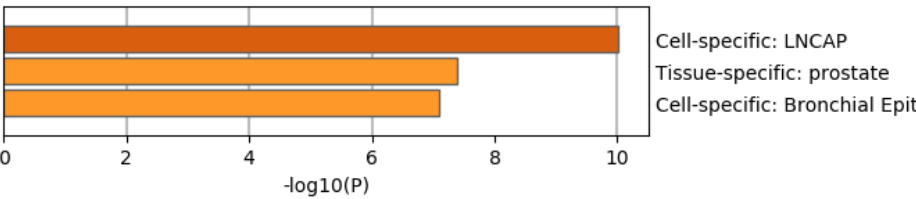
Figure 8. Summary of enrichment of the PaGenBase category of Metascape when 1785 protein-coding genes included in 1447 genomic regions selected by TD-based unsupervised FE are considered.